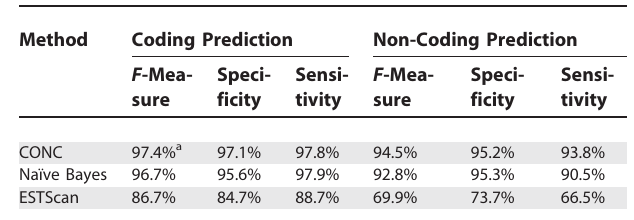
Table 1. Prediction Performance of Different